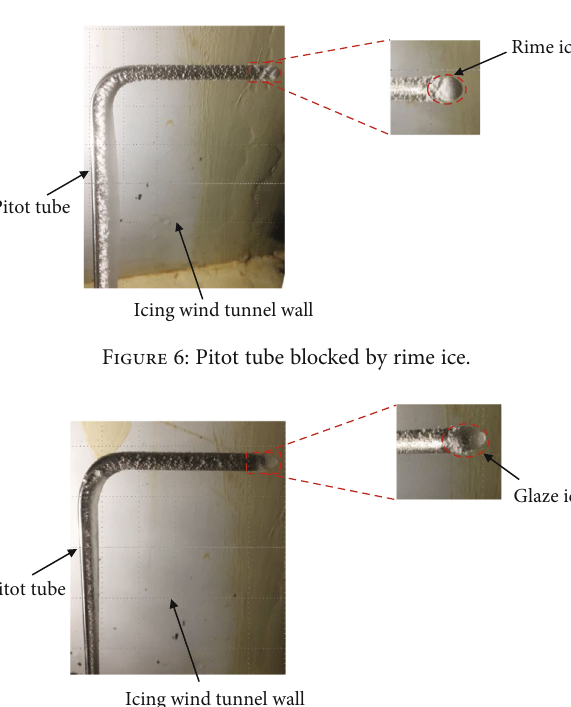
Figure 5: Total and static pressure outputs of the pitot tube after blocking by glaze ice. O – A: the entire air pressure detection system is stationary. A – B: the L-shaped pitot tube is placed into the ice wind tunnel at point A such that the total pressure hole is facing the incoming wind direction. B – C: the spray system is turned on at point B. C – D: after point C, the pitot tube is in an icy state, and icing state is glaze ice (as shown in Figure 7). After point D, the pitot tube is completely blocked by glaze ice.